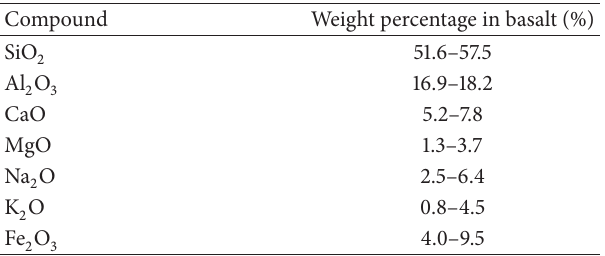
Table 1: Chemical compositions of basalt particle [12]. Table 2: Polyester resin properties.